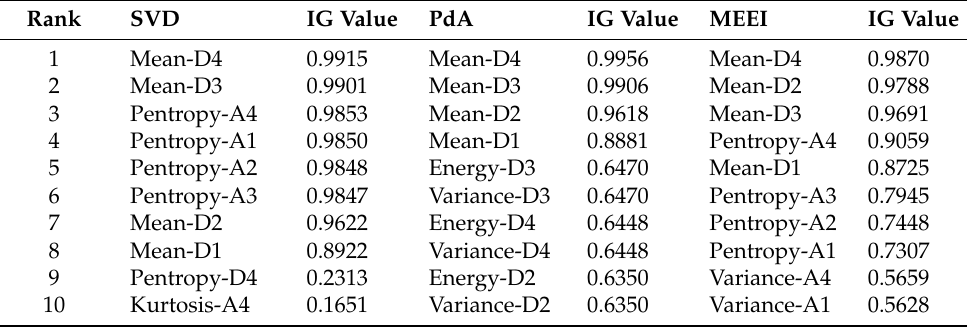
Table 9. Top 10 ranked descriptors with healthy and five pathologies.